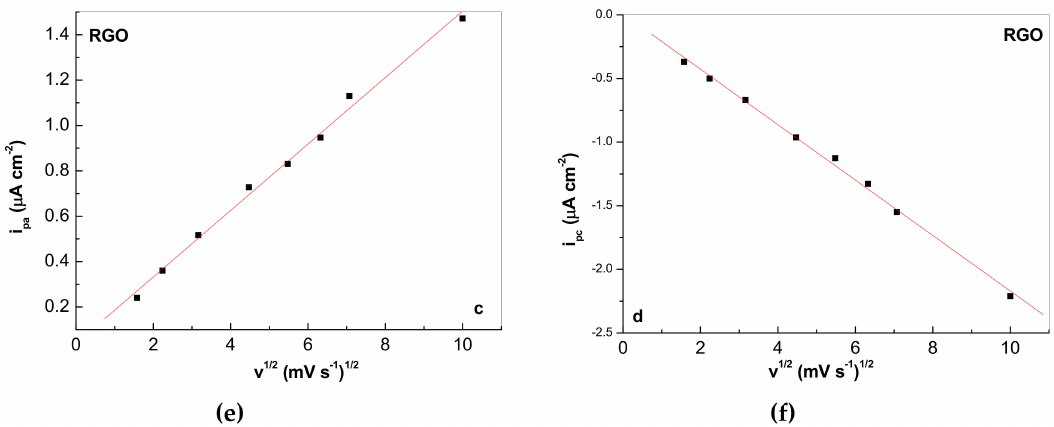
Figure 7. The 25th cyclic voltammogram recorded onto the blank Au electrode ( a ) and the Au electrode covered with the RGO sheets ( b ), when the synthesis solution consists of 0.1 M HClO 4 , 5 × 10 − 3 M 5A1N and H 4 SiW 12 O 40 with the concentration 10 − 3 M (blue curve), 2 × 10 − 3 M (red curve) or 4 × 10 − 3 M (black curve), the scan rate being equal to 50 mV s − 1 , The dependence of the current densities of the anodic and cathodic peaks with the scan rate used during the 5th cyclic voltammogram recorded onto the blank Au electrode ( c , d ) and the Au electrode covered with the RGO sheets ( e , f ), when the synthesis solution consists of 10 − 2 M 5A1N, 0.1 M HClO 4 and 2 × 10 − 3 M H 4 SiW 12 O 40 .